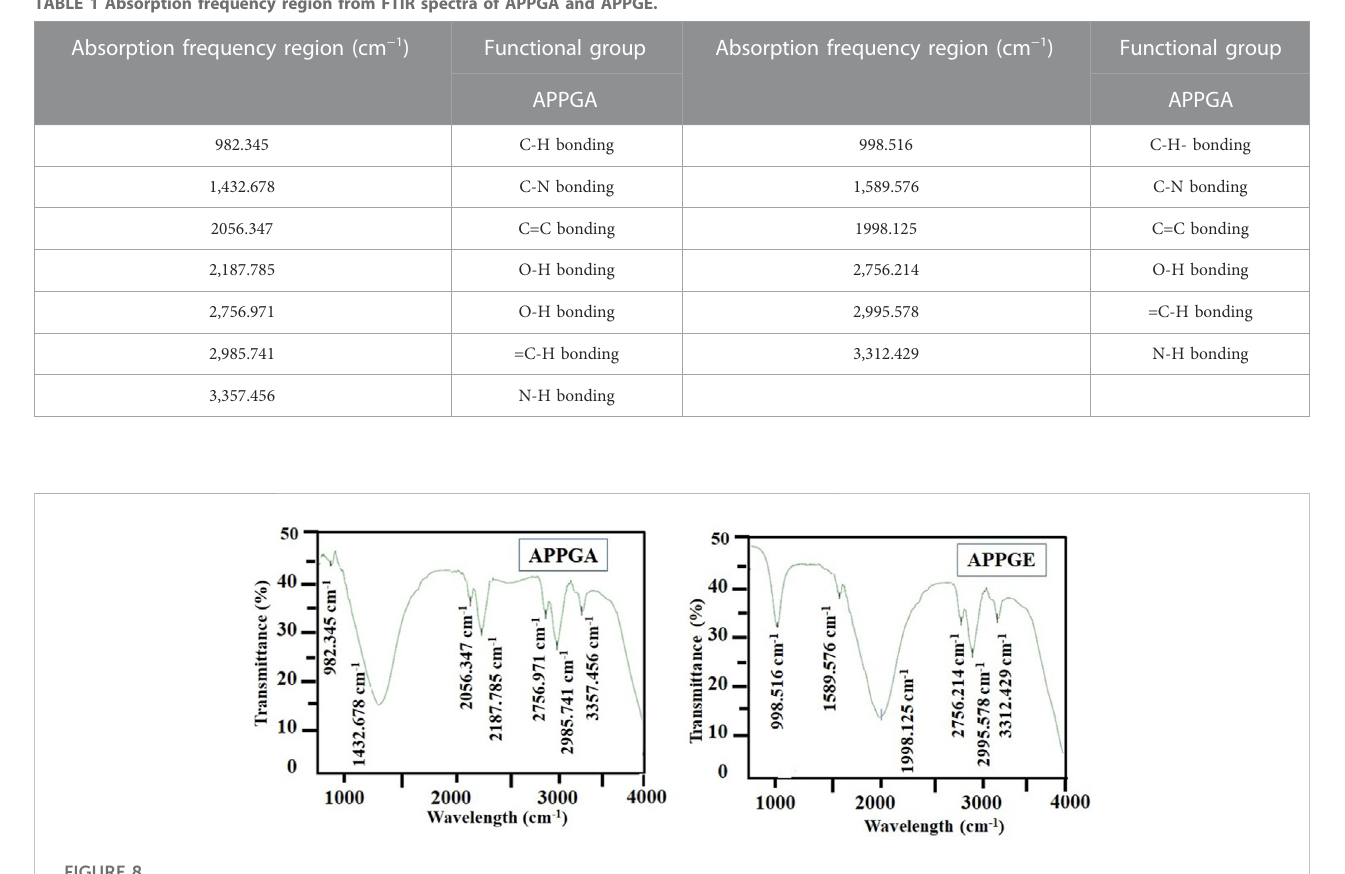
FTIR spectroscopy of the APPG leaf extract with acetone and ethanol.